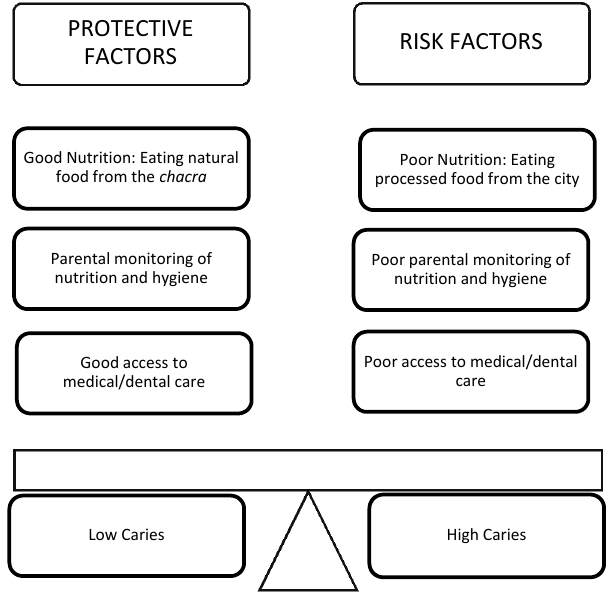
Figure 2. Depiction of the codified protective and risk factors for caries production as conceptualized based on the Caries Balance Model and social ecological children’s oral health disparities conceptual models [28,29].